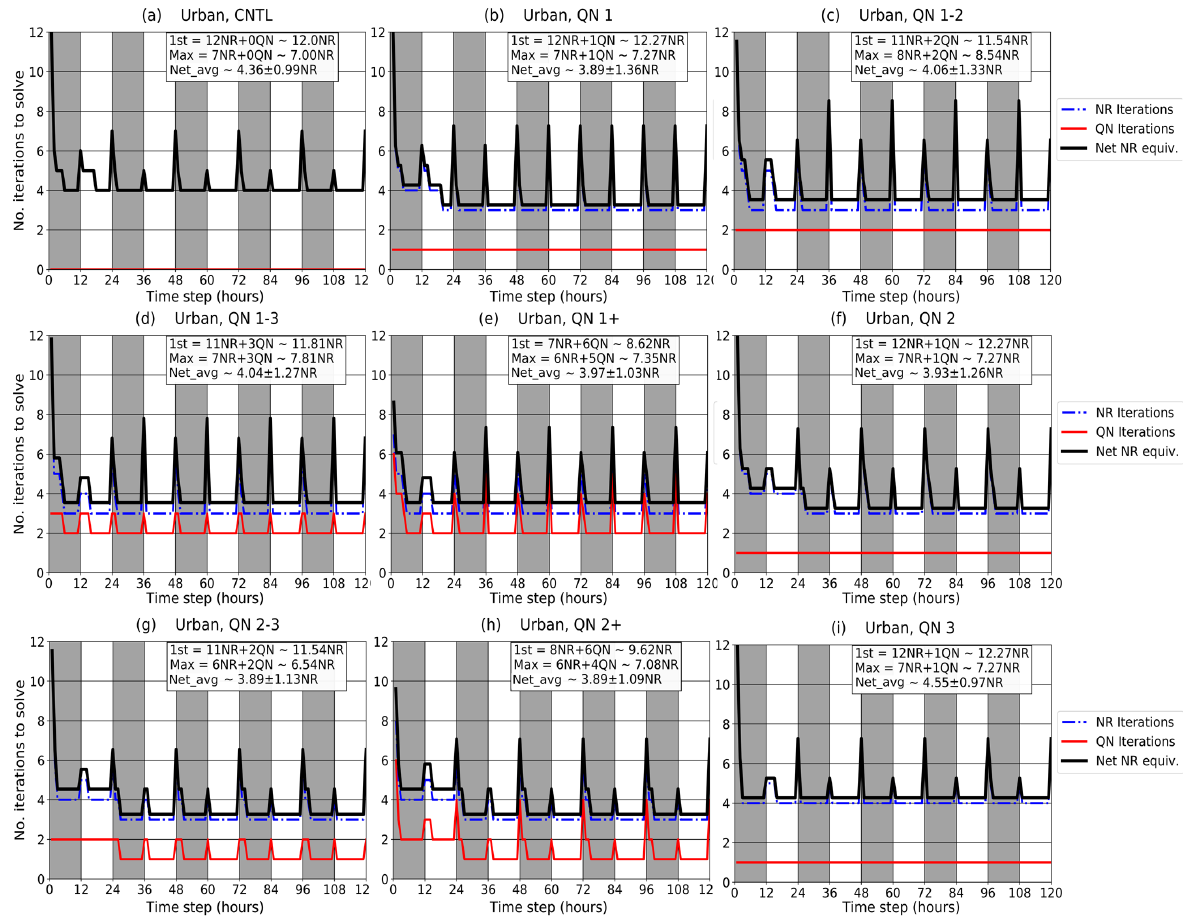
Figure 4. Plots of solver iteration (convergence) numbers for the original full NR method and QN methods, with QN pseudo-iterations only called on particular iteration(s). The CNTL scenario (a) only solves with NR iterations, and is equivalent to the solver in the release version of UKCA. The other eight panels call QN pseudo-iterations on one or more iterations at each time step. The blue dashed lines show the number of NR iterations required to converge on a stable solution, while the red line shows the number of QN pseudo-iterations required, and the black line total net number of NR-equivalent iterations to solved, calculated as NR + 0.27QN. The white bands show periods with photolysis on, and grey bands show periods with photolysis off. The text in each panel gives the number of NR and QN iterations required to converge on the first time step, the most difficult time step after the first, and on average across the whole period in NR-equivalent iterations. Table 4. Computational speed-up using the QN method in comparison to the regular Newton–Raphson method. Chemistry Number of